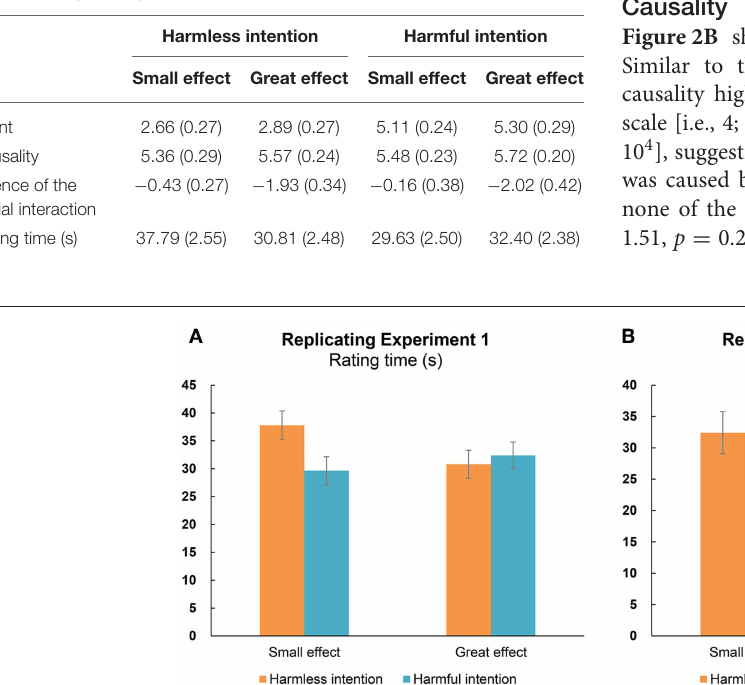
TABLE 1 | Descriptive results of different rating dimensions in replicating Experiment 1 ( M ± SE ).